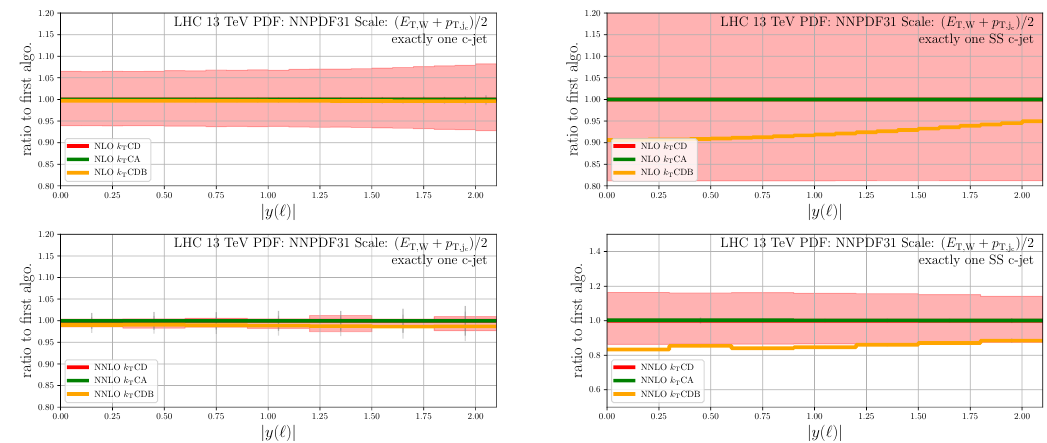
Figure 7 . Ratio of differential distributions in the rapidity of the charged lepton for the process √ pp → W + j at s = 13 TeV. The upper plots show the results at NLO QCD while the lower ones c are for NNLO QCD. The left-hand side plots are for one and only c-jet while the right-hand side ones are for one and only one c-jet of SS type. Various definition of the flavored k compared (see